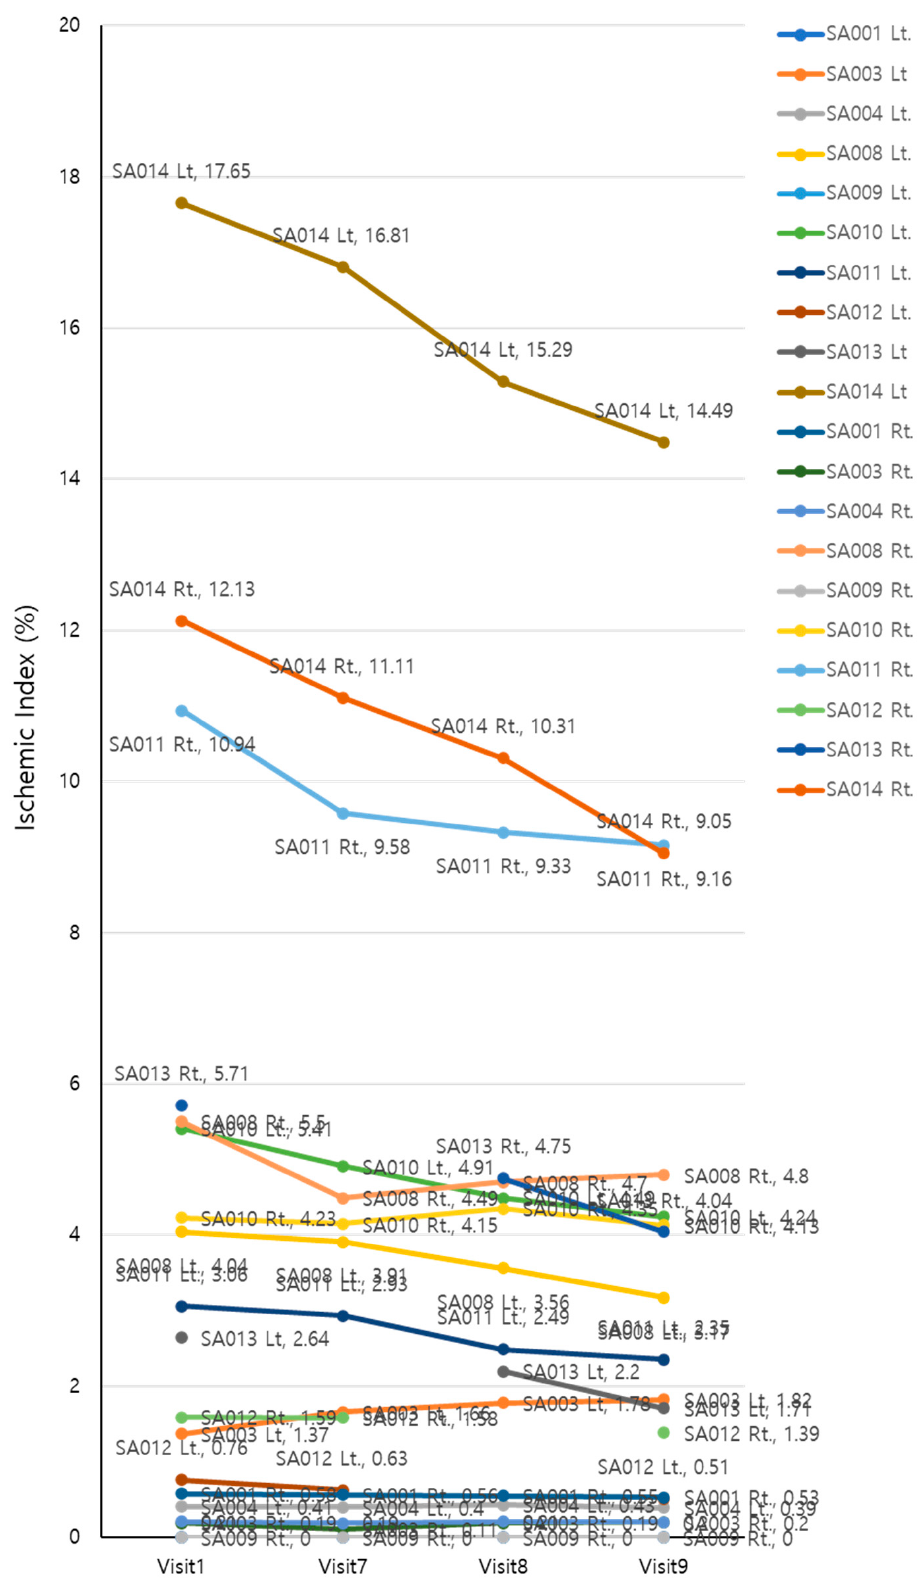
Figure 3. Changes in ischemic indexes of the participants during the study period.